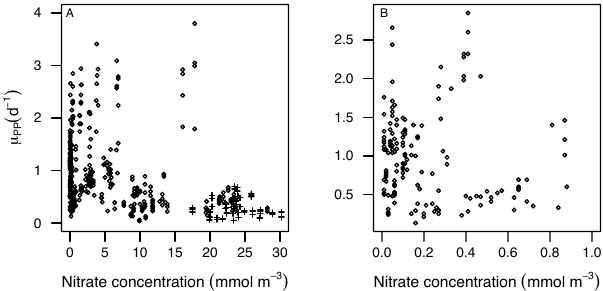
Figure 6. Relationships between in situ community growth rates ( µ PP , d − 1 ) estimated from primary production and standing stocks and nitrate concentration (a) from 0 to 40mmolm − 3 and (b) from 0 to 1mmolm − 3 from Chen and Liu (2010) Table A2 data set. Crosses represent phytoplankton communities of Table A2 sampled in HNLC regions and circles represent the rest of the phytoplankton communities from the Table A2 data